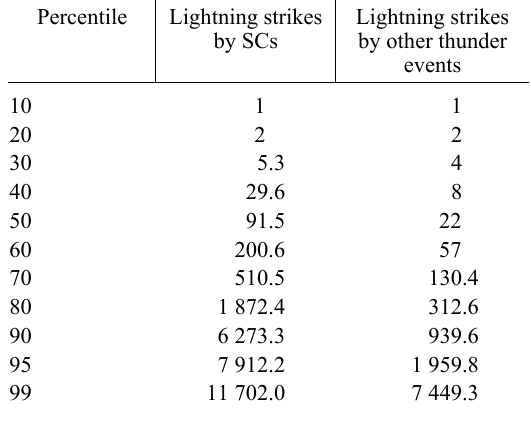
Table 4. Percentiles of lightning strikes induced by southern cyclones and by other thunder events during 2005(cid:150)2010 Percentile Lightning strikes by SCs